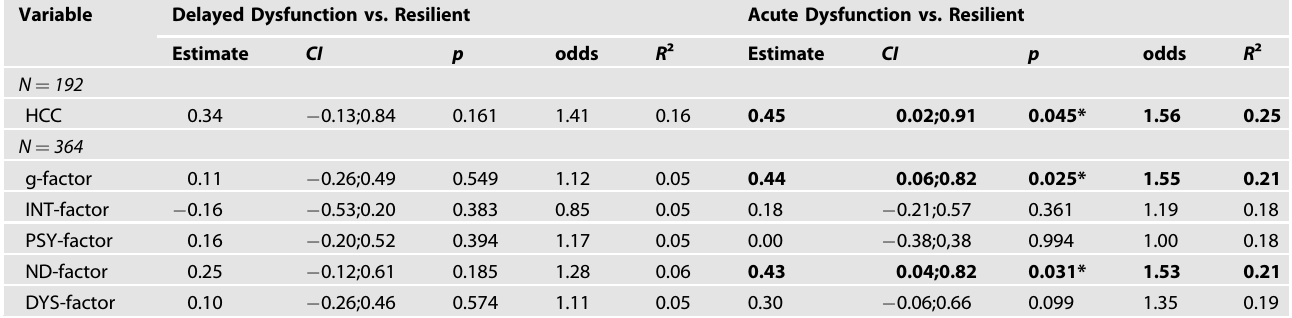
Table 3. Multiple bivariate logistic regressions: Main effects of genetic risk and long-term cortisol secretion. Variable Delayed Dysfunction vs. Resilient Acute Dysfunction vs.